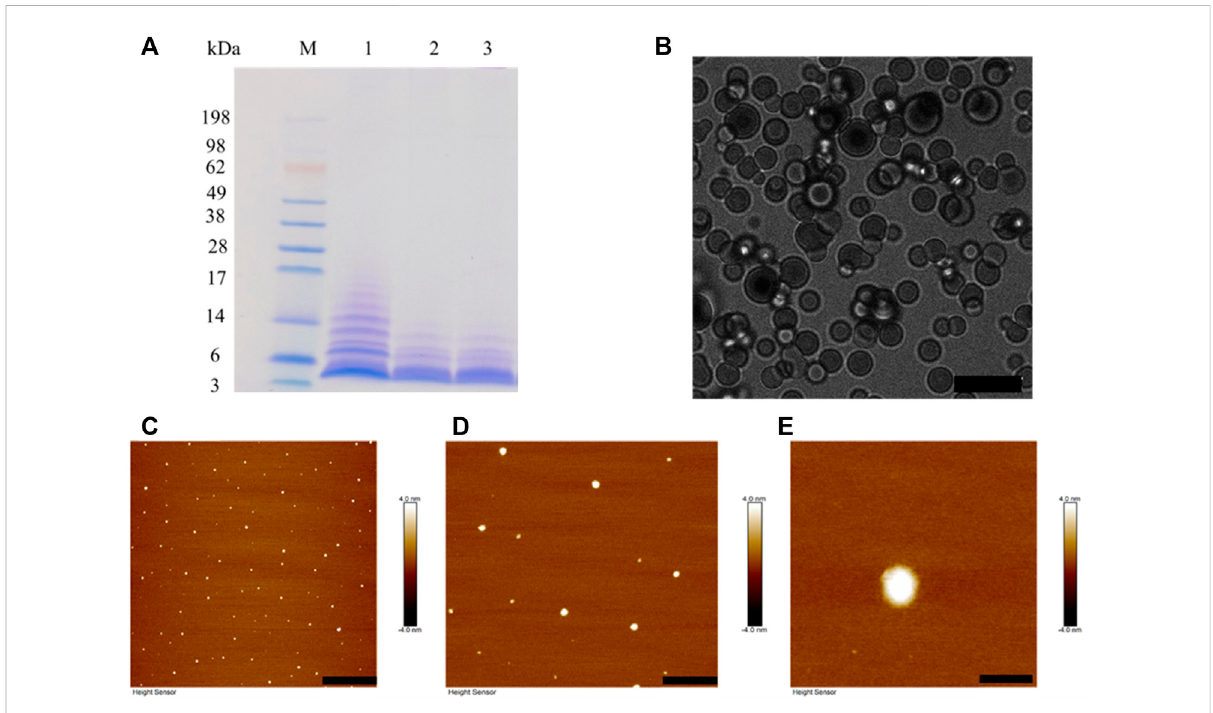
FIGURE 3 BalCP20-P3 after DTT treatment. (A) SDS-PAGE of BalCP20-P3±DTT, where M is Mark protein; Lane 1 is BalCP20-P3 of -DTT; Lane 2 is BalCP20-P3 treated by 1 mM DTT; Lane 3 is BalCP20-P3 treated by 5 mM DTT (BalCP20-P3 MW = 3.35389 kDa). (B) LSCM of BalCP20-P3 after